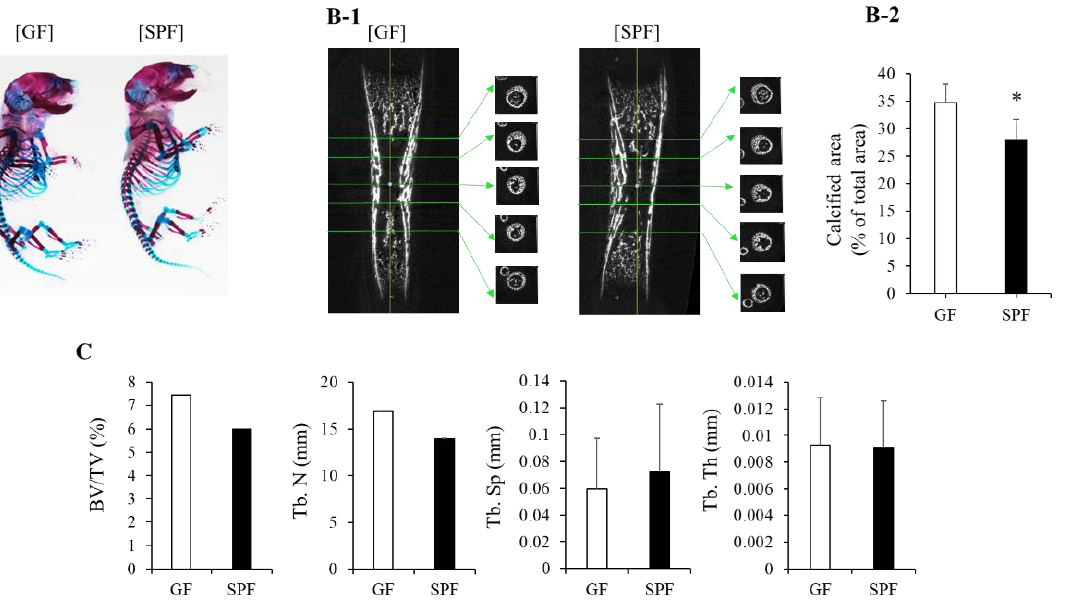
Figure 2. Morphology of GF and SPF embryos. ( A ) Skeletal preparation. ( B-1 ) Micro CT analysis of GF and SPF tibiae (E18). Corresponding sagittal and transverse planes were shown. ( B-2 ) Average of mineralized area ( µ m 2 )/total area ( µ m 2 ) from 5 different cross-sections in ( B-1 ) is shown. ( t -test, * p < 0.05). ( C ) Mineralized parameters from micro-CT analysis. The ratio of bone volume to total volume (BV/TV) and Tb.N tended to be lower in the SPF group than in GF bones. BV/TV, bone volume/tissue volume; Tb.N, trabecular number; Tb.Sp, trabecular separation; Tb.Th, trabecular thickness.